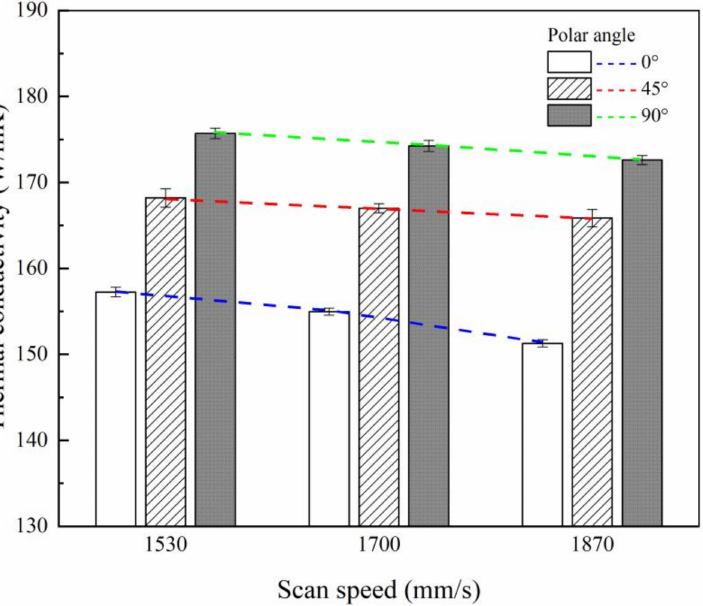
Figure 7. Comparison of thermal conductivity as a function of the laser scan speed at a test tempera- ture of 25